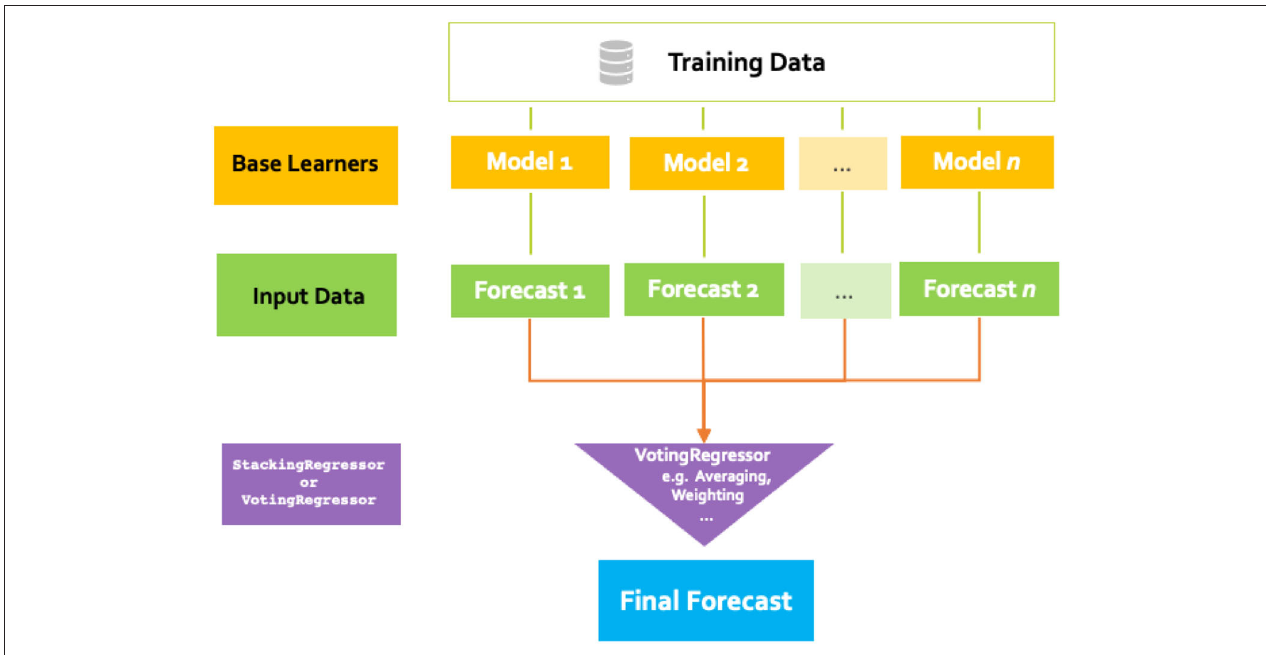
FIGURE 3 | Fusion process according to the ensemble learning